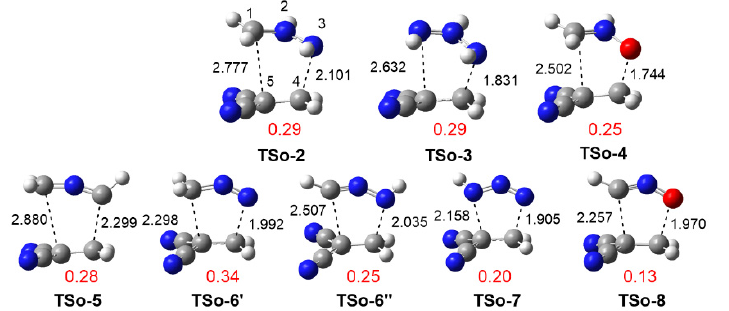
Figure 5. MPWB1K/6-311G(d,p) gas phase optimized geometries of the TSs associated with the ortho regiosimeric path of the 32CA reactions between TACs 1–8 and DCE 10 . Distances are given in angstroms, Å, while the GEDT values computed at the TAC framework, in red, are given in number of electrons, e.